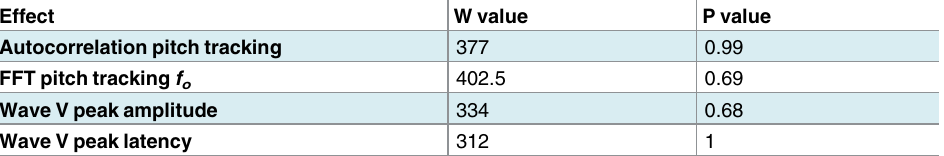
Table 4. Mann-Whitney-Wilcoxon test for subcortical effects between musicians and nonmusicians.